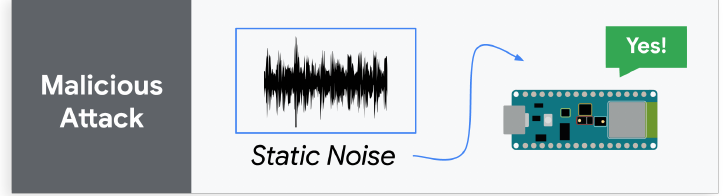
Figure 10. Students attack a pretrained KWS model. with malicious static noise. This triggers a spotting of the keyword "yes," revealing the need for security and